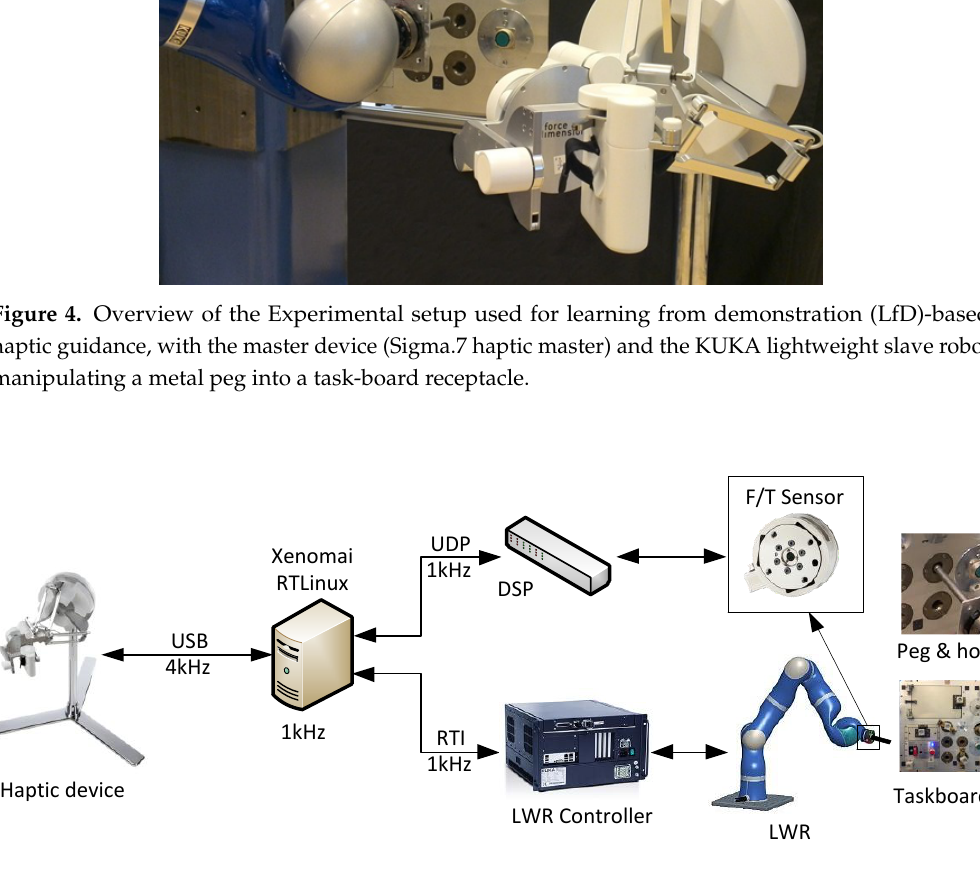
Figure 5. Software and Hardware architecture of the experimental telemanipulation setup as available at the Telerobotics Laboratory of the European Space